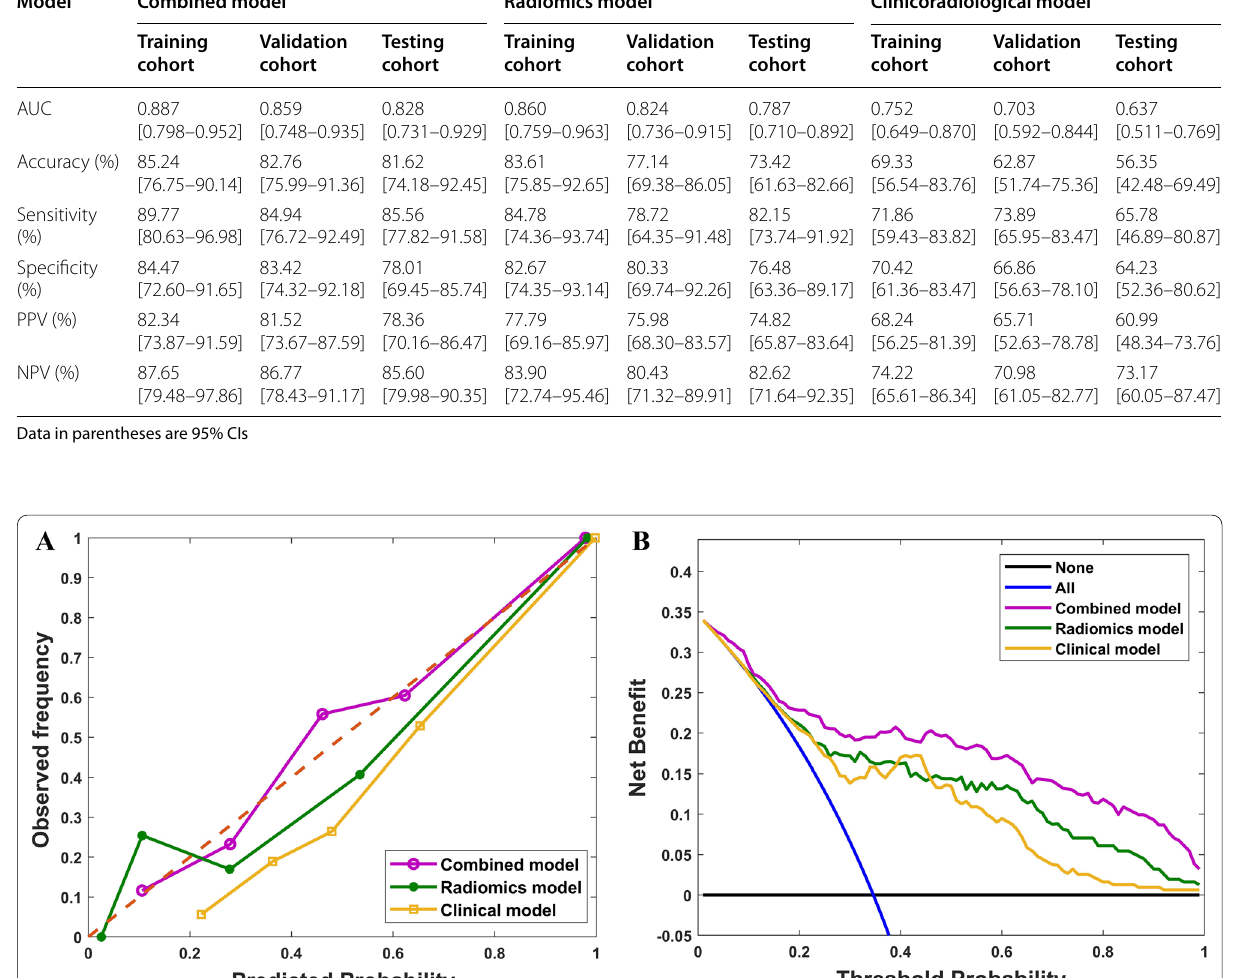
Table 6 Predictive performance of combined model, radiomics model, and clinicoradiological model